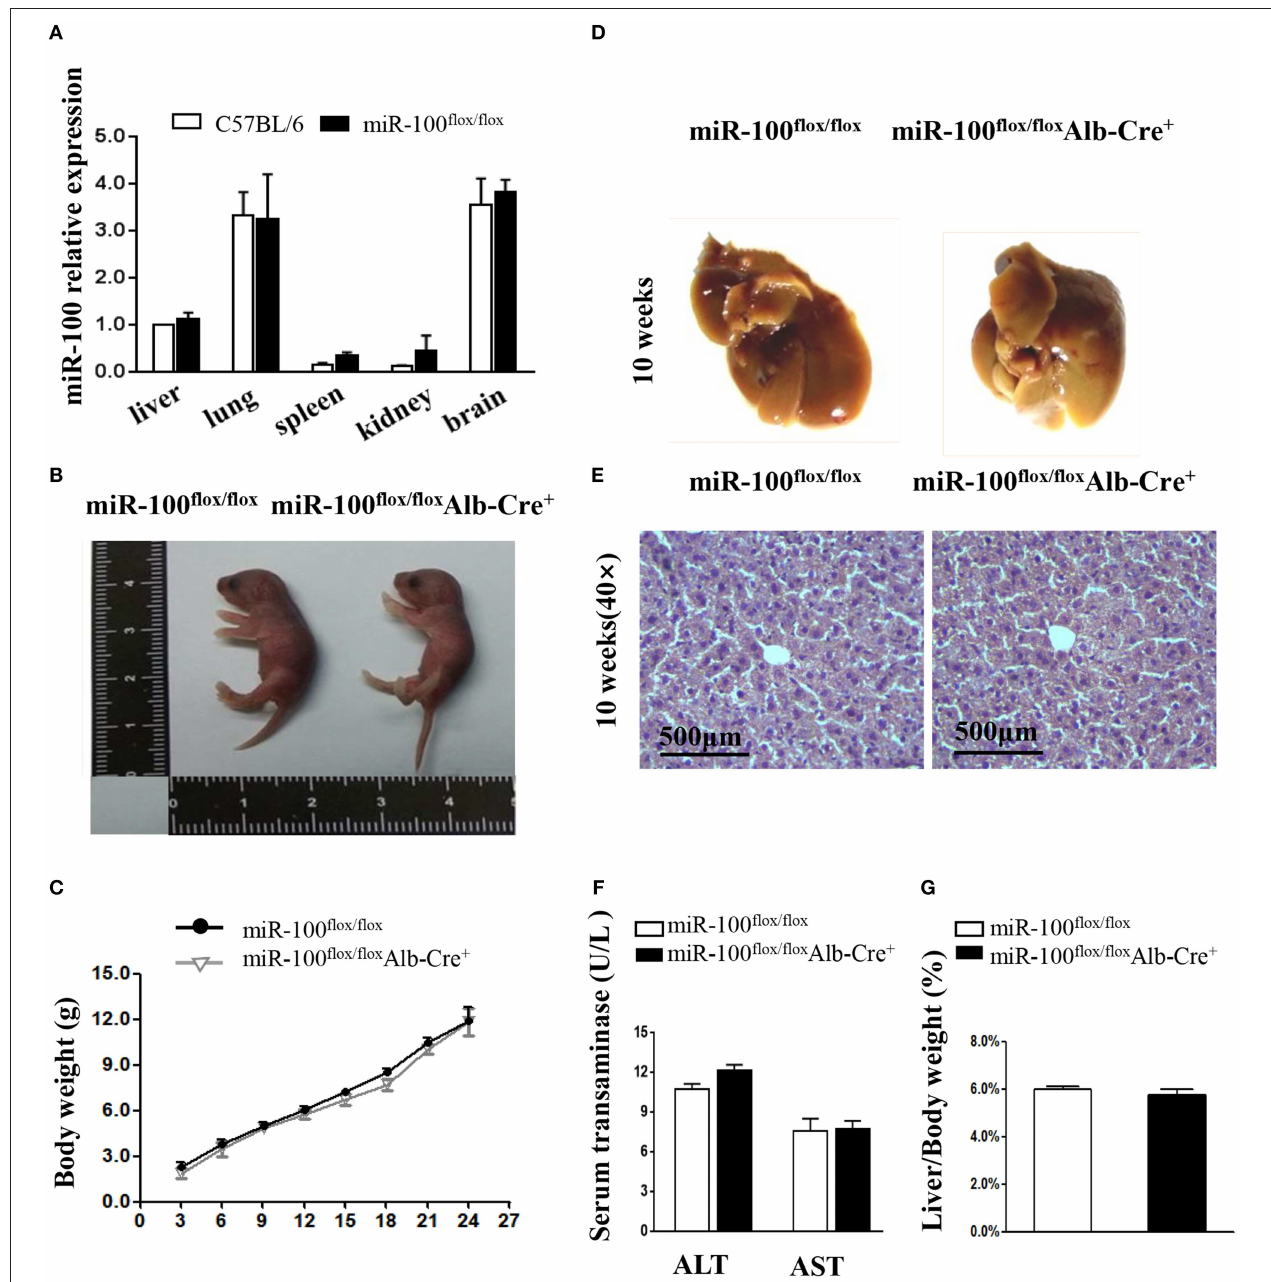
FIGURE 4 | Phenotype analysis in the new born and adult hepatocyte-specific miR-100 deletion mice. (A) QRT-PCR analysis of miR-100 expression in the indicated tissues from miR-100 flox / flox and C57BL/6 mice. U6 was used as an internal control. The expression level was normalized and are presented relative to the level expressed in the liver. (B) Representative photographs of miR-100 flox / flox Alb-Cre + and miR-100 flox / flox newborn littermates. (C) Growth curve of miR-100 flox / flox Alb-Cre + and miR-100 flox / flox littermates. F2 pups were weighed every 3 days from postnatal day 3. Data are mean ± SEM from 3 mice of each group. (D–G) Gross and histological analyses of livers from the 10-week-old miR-100 knock-out mice and control mice. Representative liver photographs (D) and liver tissues HE staining (E) were shown. Serum transaminase activity (F) and liver weitht/ body weight (LW/BW) ratios (G) of miR-100 flox / flox Alb-Cre + and miR-100 flox / flox littermates were measured. Data are mean ± SEM from each group ( n = 3/group). Scale bars represent 500 µ